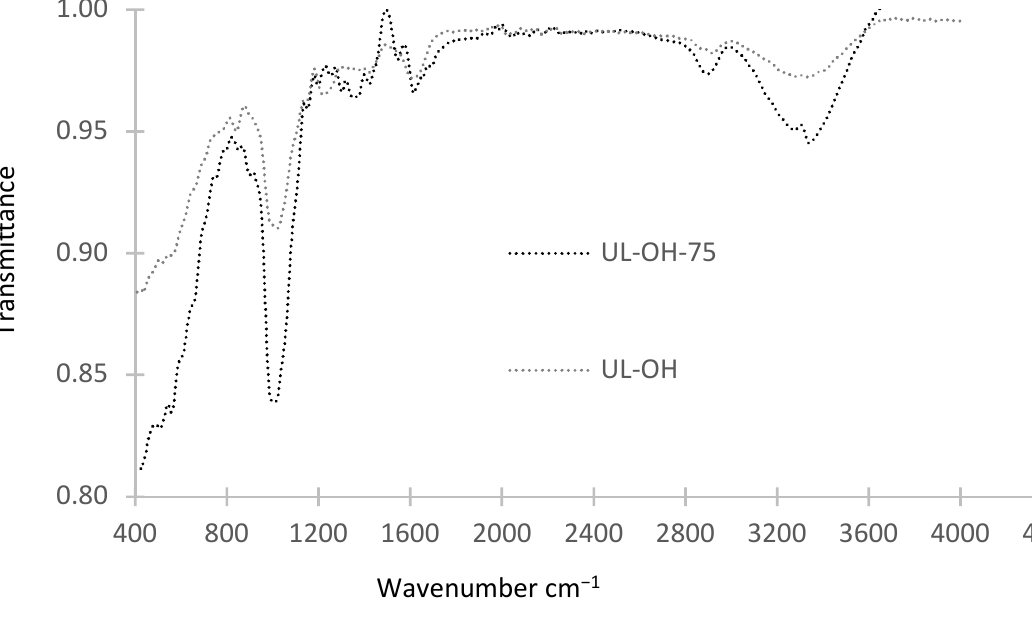
Figure 4. IR spectra of the base-treated (UL-OH) dry U. lactuca before and after 75 min of contact with MB.